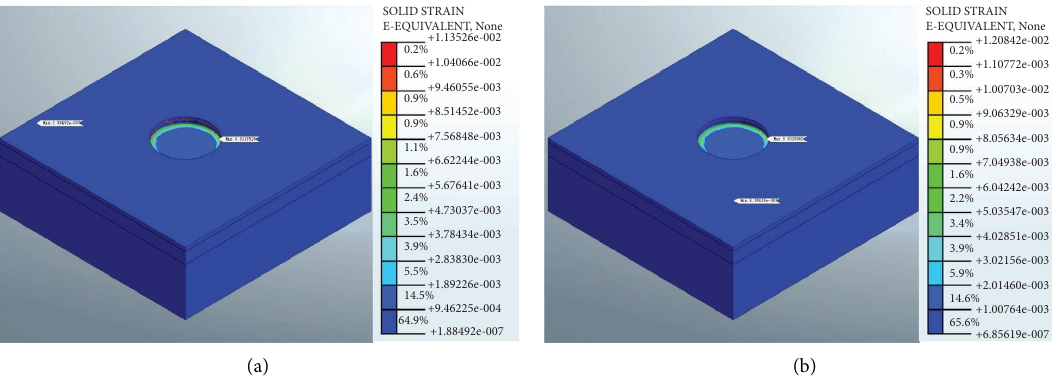
Figure 12: Working condition 3. Equivalent soil strain (a) without pore water pressure and (b) with pore water pressure applied.